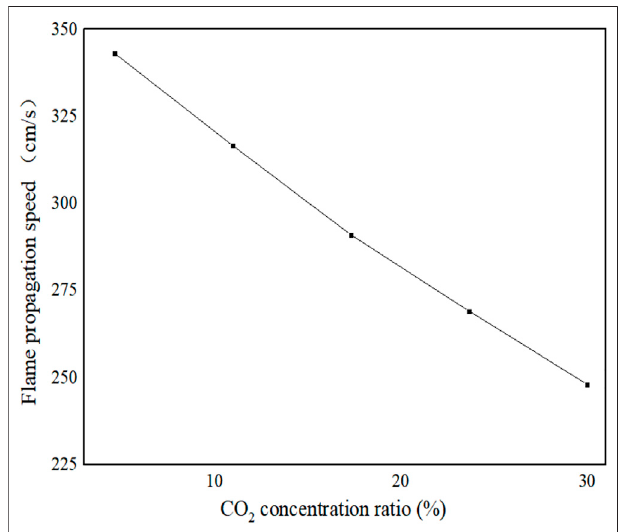
FIGURE 12 | Variation law of reaction equilibrium temperature with CO 2 concentration.